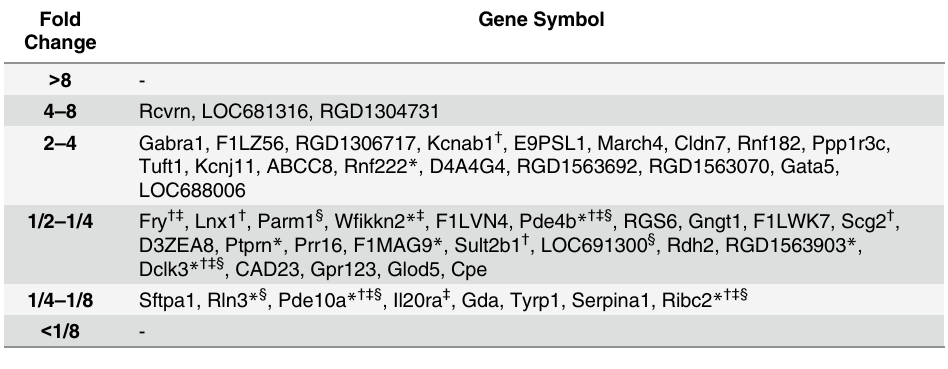
Table 2. Genes with consistent differential expression in the DCN group relative to the Sham group. These genes displayed significant (adjusted-p < 0.001) differentials across 2 analyses: DCN-day vs Sham- day and DCN-night vs Sham-night. Genes are classified by the least-extreme fold change across both analy- ses. The complete results for these analyses are available in the SI (S2 Dataset). Fold Gene Change